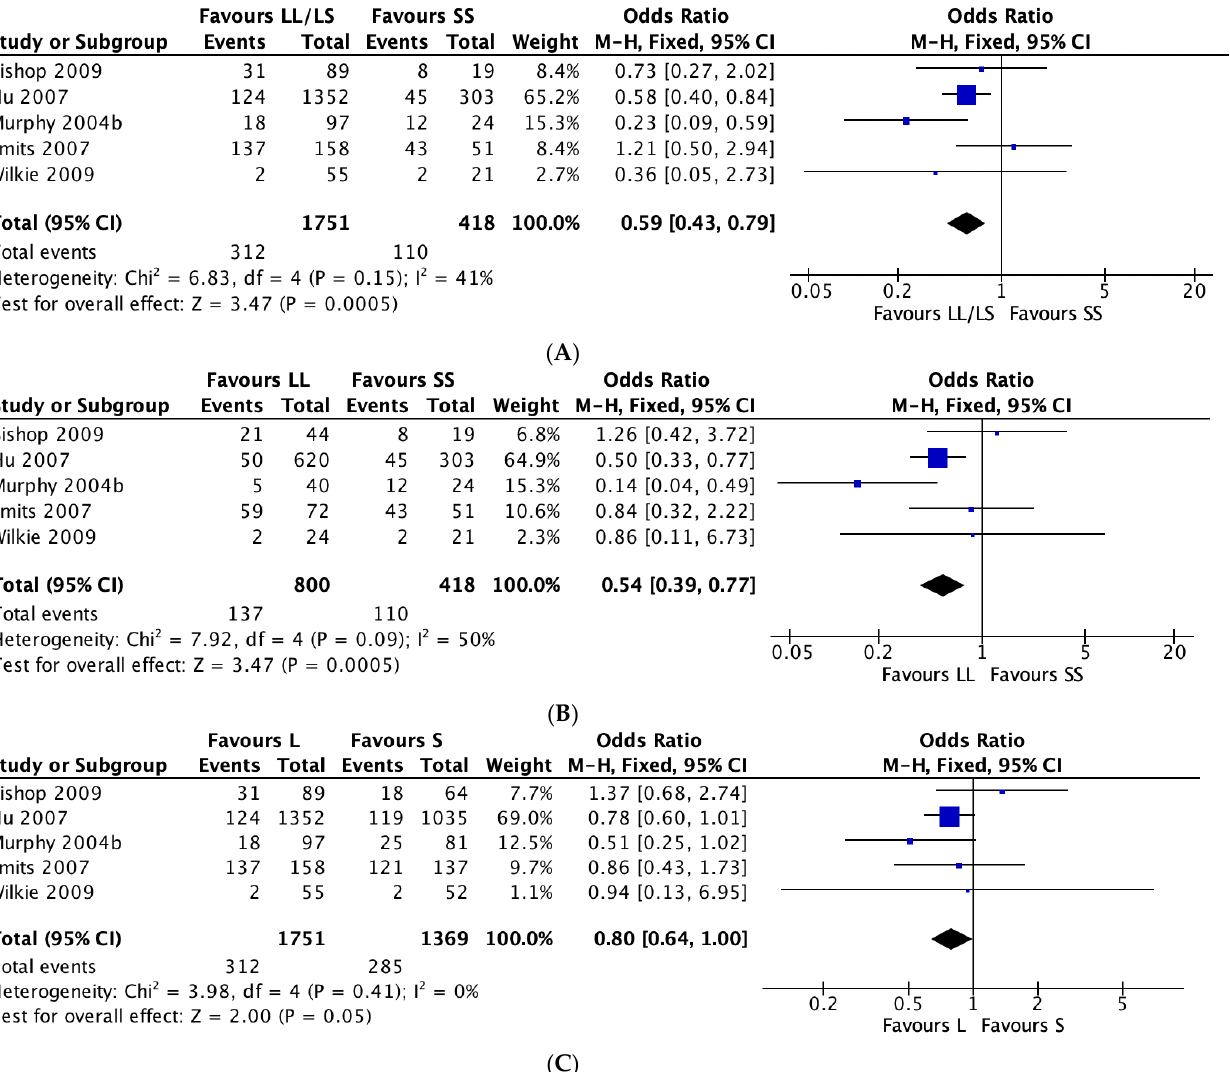
Figure 4. Forest plots of 5-HTTLPR polymorphisms and adverse drug reactions in studies with participants of European background taking SSRIs by genotype comparisons. ( A ) LL/LS vs. SS; ( B ) LL vs. SS; ( C ) L vs.